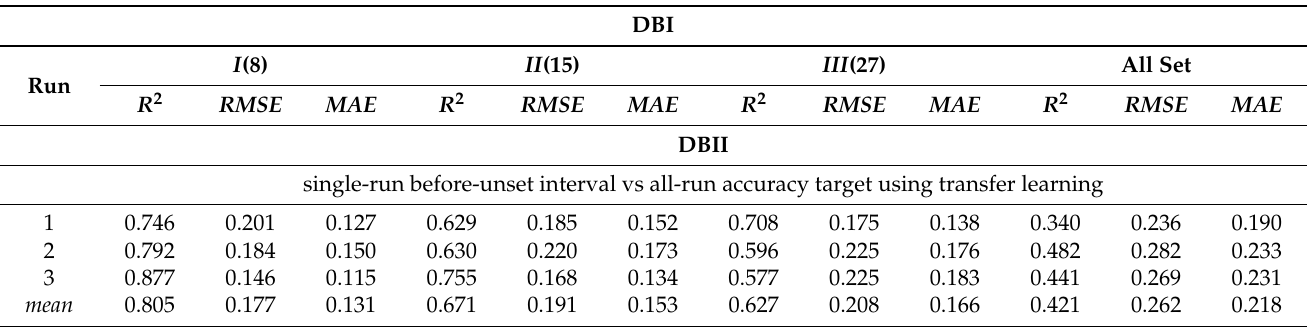
Table 6. Cont. DBI